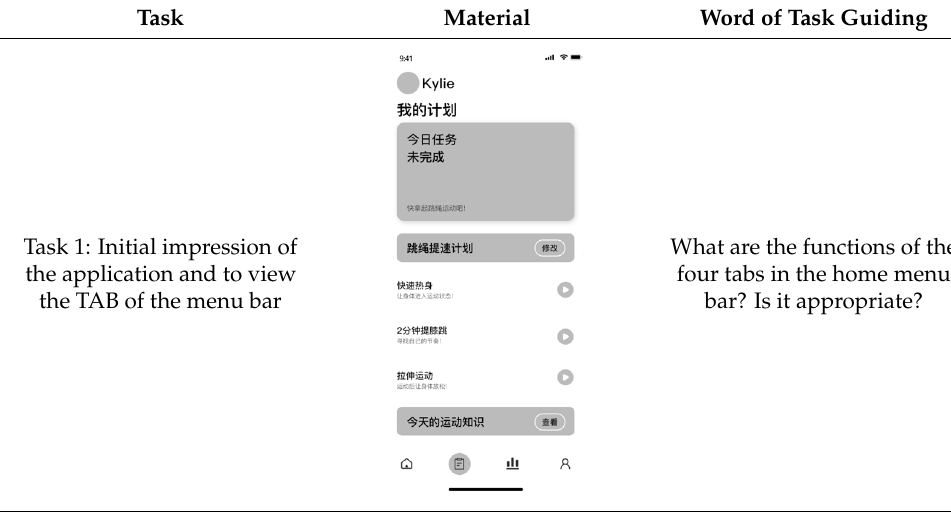
Table A4. Usability test tasks.